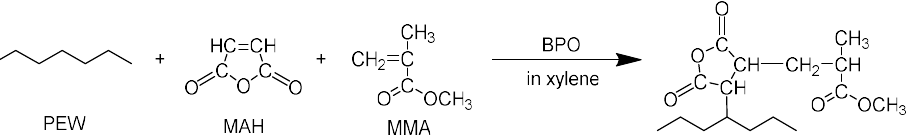
and methyl methacrylate